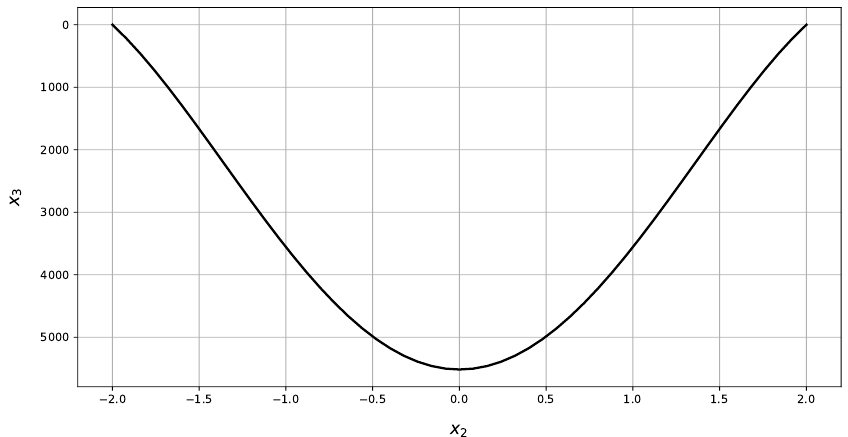
Figure 11. The bending moments M 22 in section x 1 = 0 of a rectangular plate with two opposite edges simply supported and the other